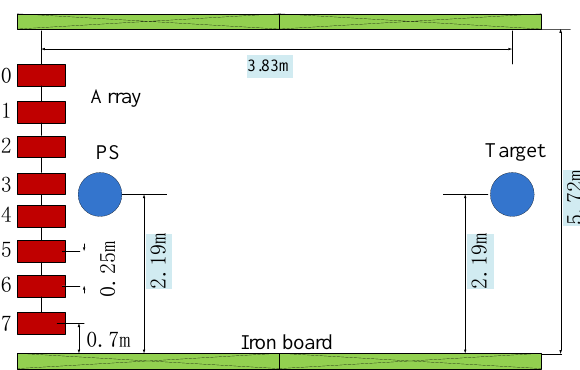
Figure 10. The data acquisition field.